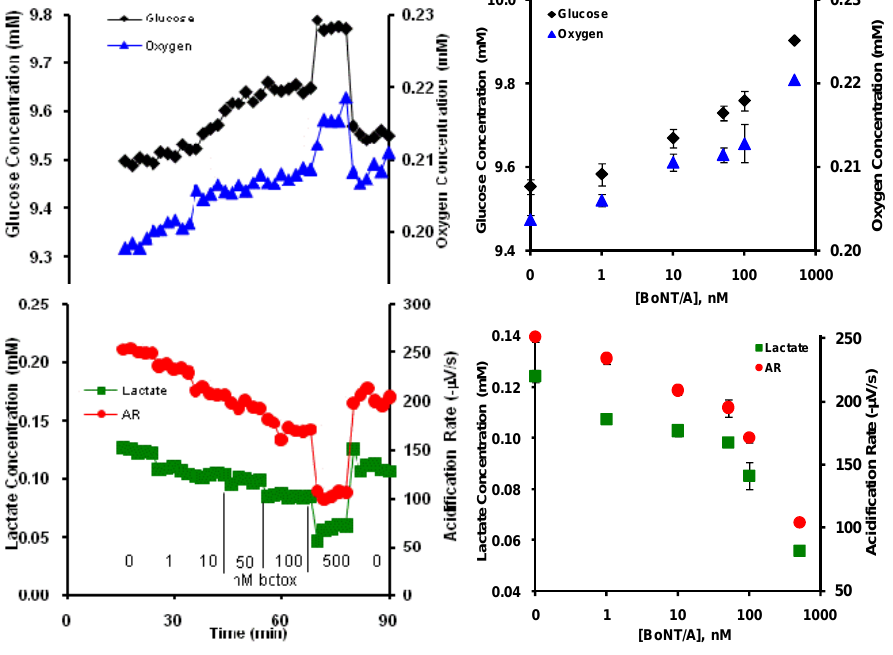
Figure 2. Representative BoNT/A kinetic metabolic profiles and partial dose response curves in [substrate] vs. log [BoNT/A] with sequential increasing concentration of